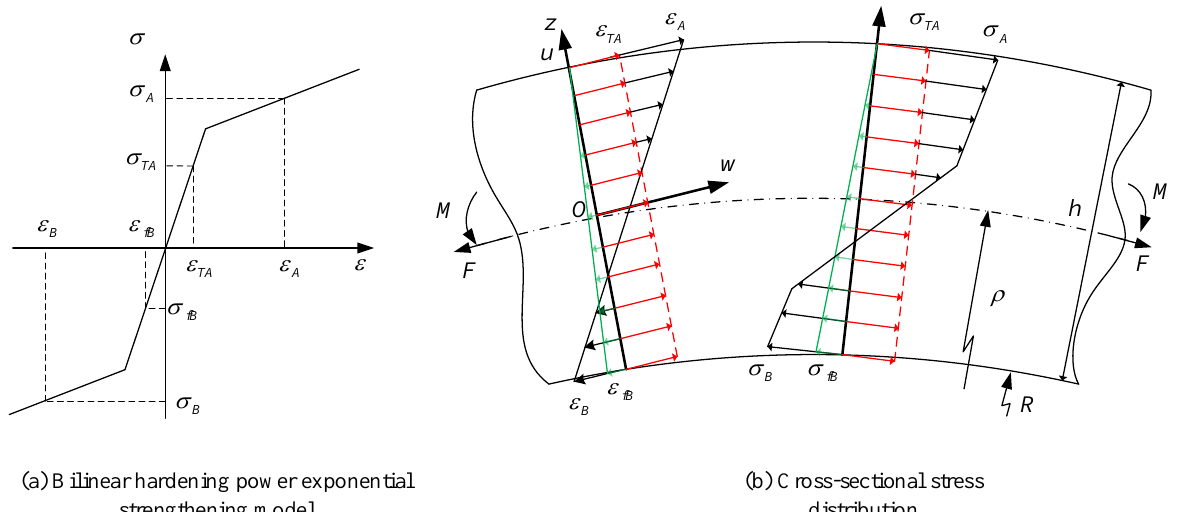
Figure 5. Stress–strain distribution of the stretch-bend section. ( a ) Bilinear hardening power expo- nential strengthening model; ( b ) cross-sectional stress distribution; where, wou is the neutral layer coordinate system; σ and ε are the total stress and total strain of the section, respectively; σ A and ε A are the total stress and total strain of the outermost layer of the section, respectively; σ fB and ε fB are the frictional shear stress and strain of the contact interface between the inner layer of the section and the mold, respectively; σ B and ε B are the total stress and total strain of the innermost fiber, respectively.